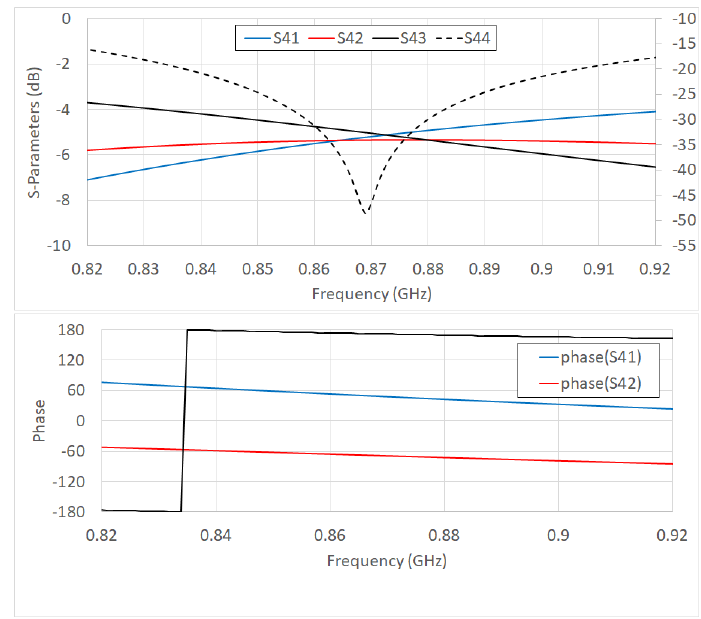
Figure 5. Phase and amplitude simulation of feeding circuit